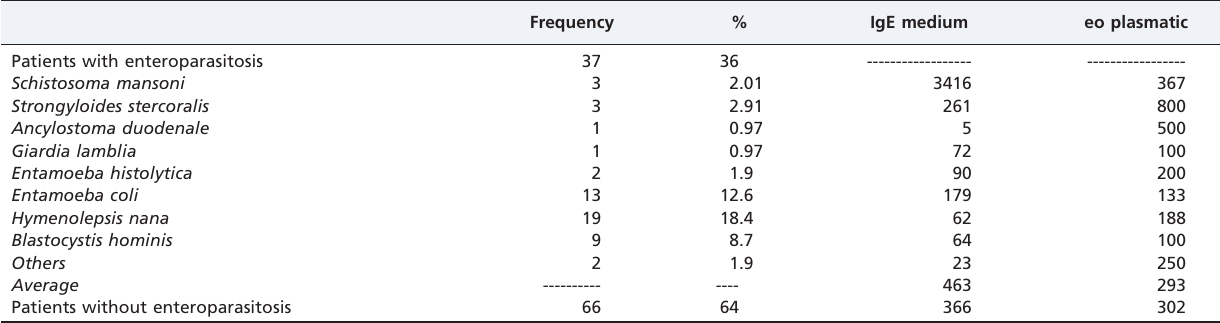
Table 2 - Eosinophil (eo) count and serum IgE levels in patients with and without